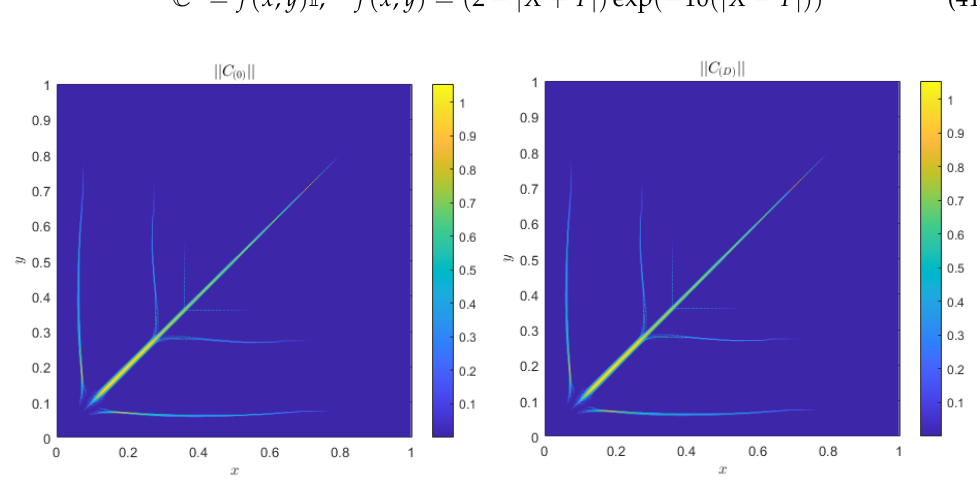
Figure 6. Comparison between T EST N and T EST O. Here, the initial condition is defined in Equa- tion (41), with D = 0 on the left and D = 10 − 5 on the